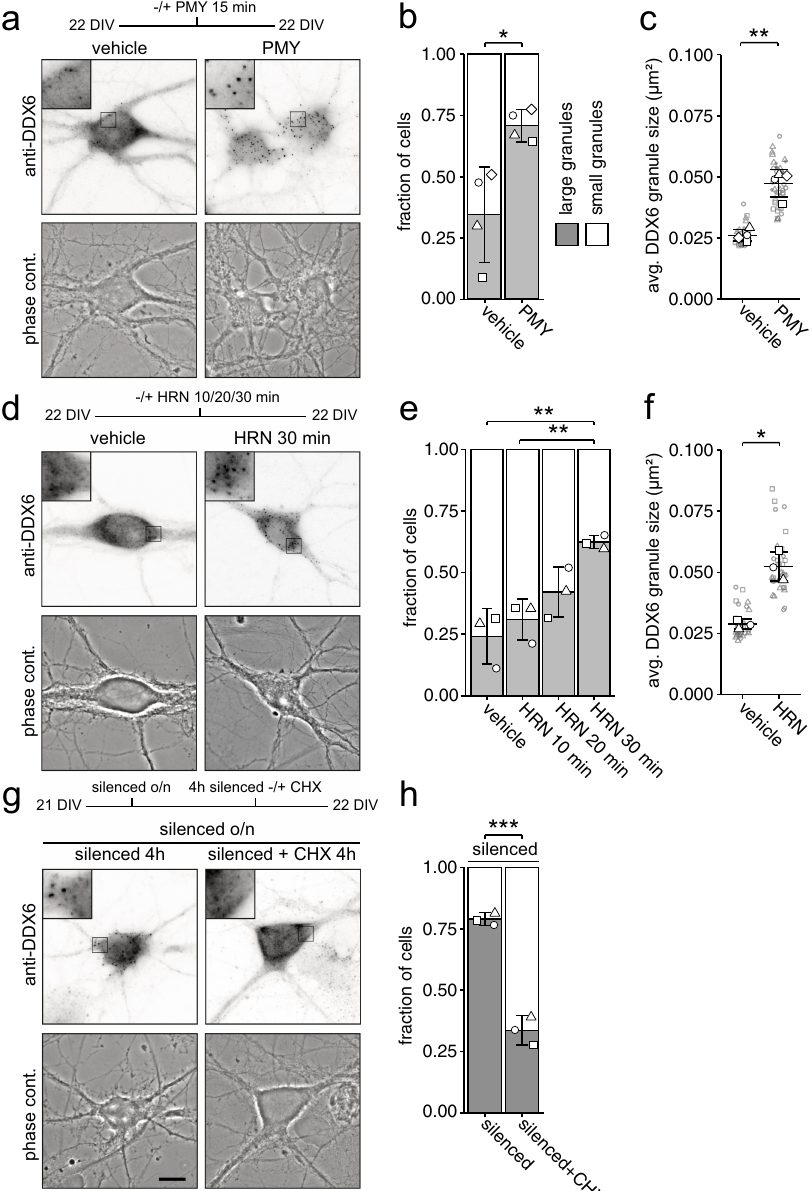
Fig. 4 DDX6 granule assembly is facilitated by the availability of cytoplasmic non-translating mRNAs. a , d , g Experimental outline and representative examples of DDX6 immunostainings and phase contrast pictures of 22 DIV hippocampal neurons in culture under 15 min vehicle or puromycin (25 µ M) treated conditions ( a ), under 30 min vehicle (DMSO) or harringtonine (2 µ g/mL) treated conditions ( d ), and under silenced (100 µ M CNQX, 50 µ M AP5, 1 µ M TTX) conditions, followed by 4 h additional silencing or silencing + CHX ( g ). Abbreviations: PMY = puromycin, HRN = harringtonine, CHX = cycloheximide. Boxed regions in images are displayed as magni fi ed insets. Scale bars 10 µ m. b , e , h Bar plots displaying quanti fi cation of cell population by fraction of cells containing either large or small DDX6 granules as exempli fi ed in ( a ), ( d ) and ( g ). Distinct dot symbols indicate biological replicates. At least 100 cells/condition/experiment were quanti fi ed. n = 4 ( b ) and n = 3 ( e , h ) biologically independent experiments). c , f Dot plots displaying average DDX6 granule size of individual cell bodies. Small gray symbols represent single cells while larger white symbols indicate the average of each replicate. Data represents mean of three or four independent neuronal cultures. n = 4 ( c ) and n = 3 ( f ) biologically independent experiments). Asterisks represent p -values obtained by two-sided Student ’ s t -test ( b , c , f , h ) or Tukey ’ s test post-hoc to one-way ANOVA analysis ( e ) (* p < 0.05, ** p < 0.01, *** p < 0.001). p = 0.0276 ( b ), p = 0.0022 ( c ), F 3,8 = 0.00333 ( e ), p = 0.0096 ( f ), p = 0.00084 ( h